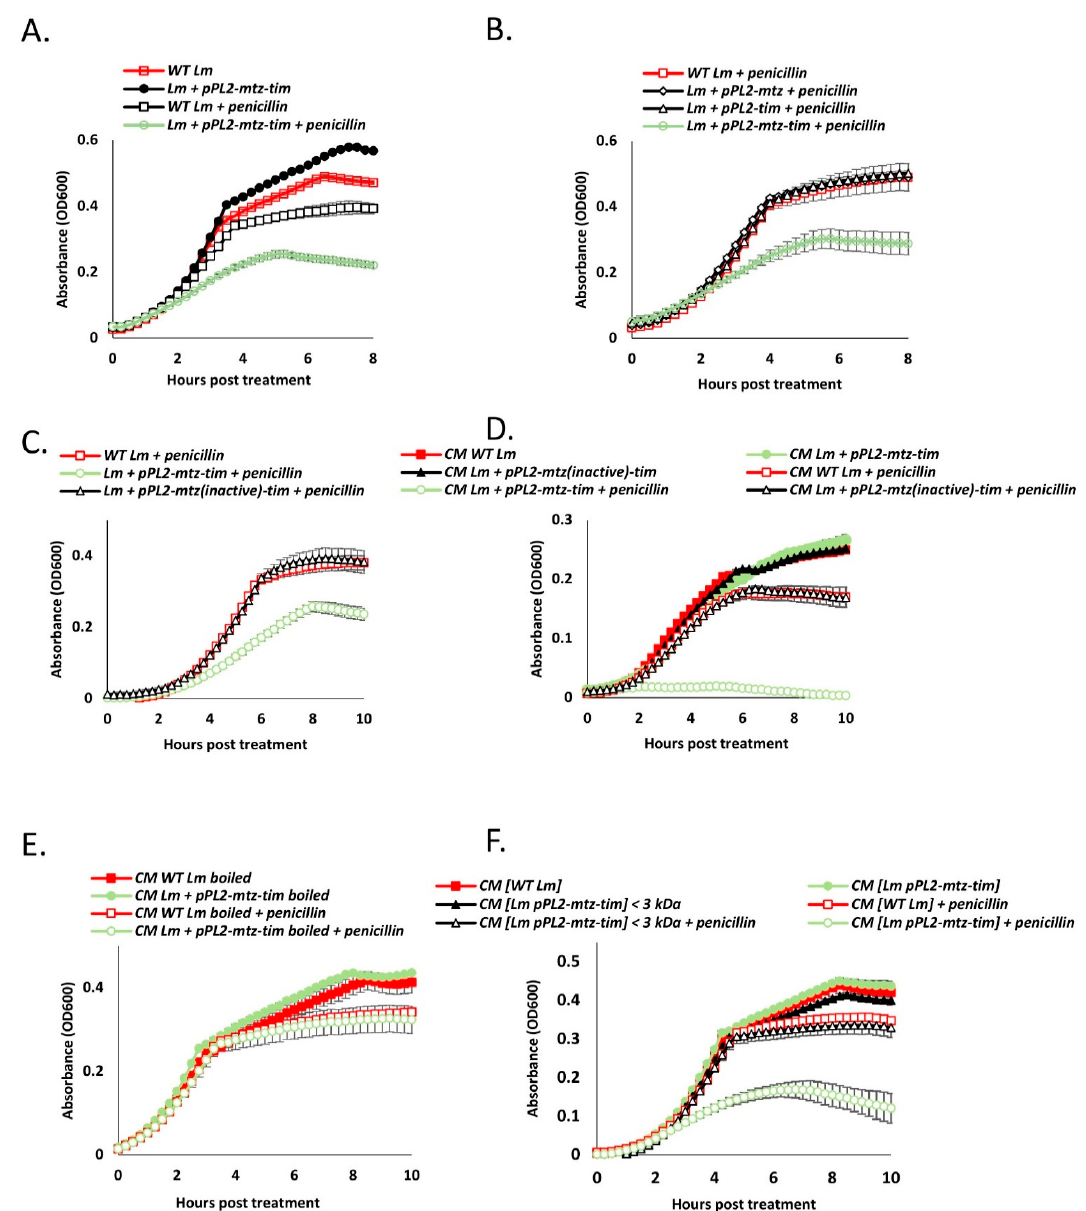
Figure 7. Ectopic expression of Mtz-Tim sensitize Lm to penicillin. ( A ) Growth analysis in BHI media of WT Lm , and WT Lm harboring pPL2 plasmid expressing mtz-tim from an inducible p tetR promoter (pPL2- mtz-tim ) at 37 ◦ C, with and without addition of penicillin, as indicated. ( B ) Growth analysis in BHI media of WT Lm , and WT Lm harboring pPL2 plasmid expressing mtz or tim or both from an inducible p tetR promoter (pPL2- mtz , pPL2- tim and pPL2- mtz-tim , respectively) at 37 ◦ C, with the addition of penicillin. ( C ) Growth analysis in BHI media of WT Lm , and WT Lm harboring pPL2 plasmid expressing mtz-tim or mtz mutated at position E136A with tim from an inducible p tetR promoter (pPL2- mtz-tim and pPL2- mtz(inactive)-tim , respectively) at 37 ◦ C, with the addition of penicillin. ( D ) Growth analysis of WT Lm in conditioned media (CM) of WT Lm , and WT Lm expressing mtz-tim or mtz mutated at position E136A with tim from an inducible p tetR promoter (pPL2- mtz-tim and pPL2- mtz(inactive)-tim , respectively) at 37 ◦ C, with or without addition of penicillin. ( E ) Growth analysis of WT Lm in conditioned media (CM) or in boiled CM of WT Lm or WT Lm expressing mtz - tim from an inducible p tetR promoter (pPL2- mtz-tim ), with or without addition of penicillin at 37 ◦ C. ( F ) Growth analysis of WT Lm in conditioned media (CM) or in CM depleted of proteins >3 kDa (CM < 3kD) of WT Lm or WT Lm expressing mtz - tim from an inducible p tetR promoter (and pPL2- mtz-tim ) at 37 ◦ C, with or without addition of penicillin. Data in A–F represent three independent experiments and error bars represent the standard deviation of